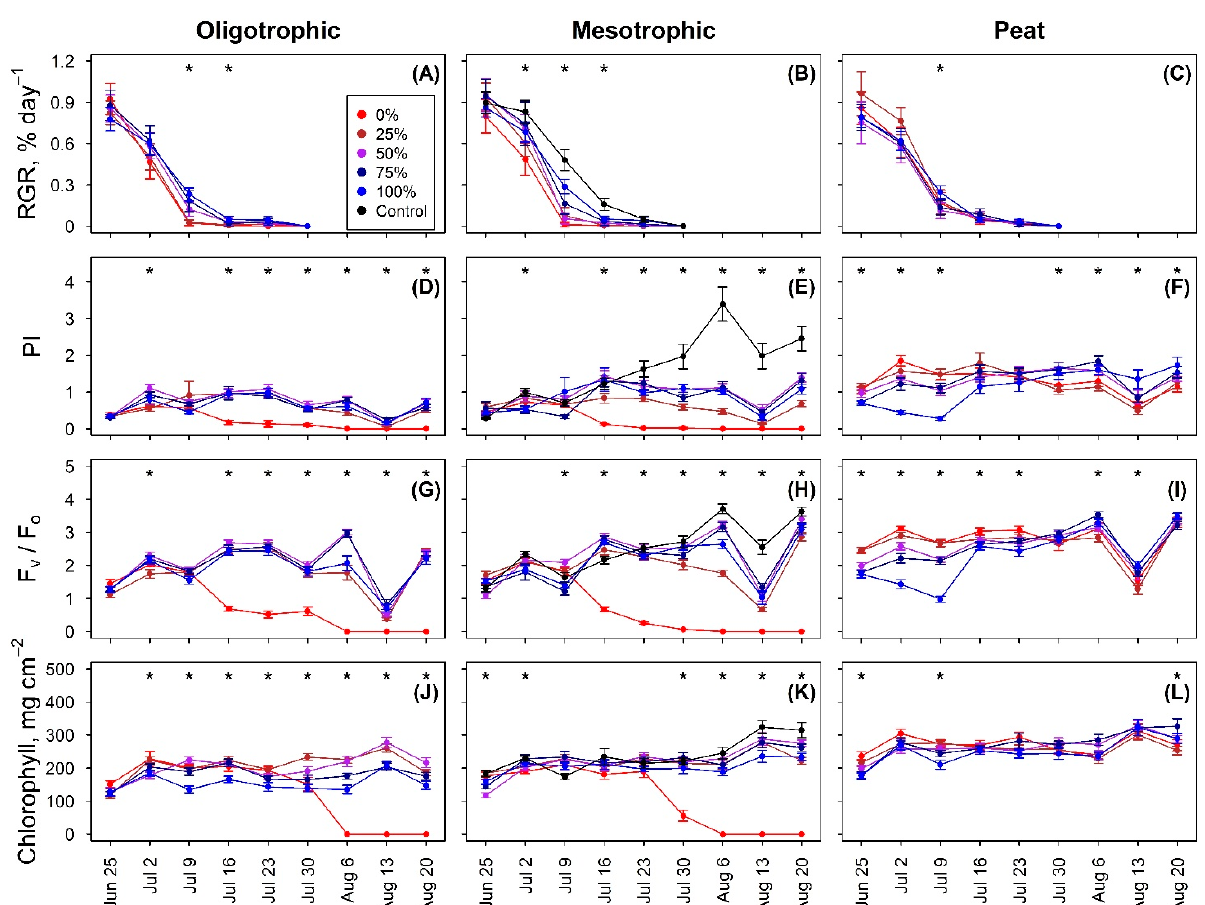
Figure 4. The intra-annual dynamics of relative growth rate (RGR, A – C ), photosynthetic performance index (PI; D – F ), F v /F 0 ratio ( G–I ), and chlorophyll concentration ( J–L ) in the second-year needles of the third-year seedlings of Norway spruce according to soil type and irrigation intensity (proportion of natural precipitation; indicated by colours). The whiskers denote 95% confidence intervals. The asterisks above the points indicate significant ( p -value < 0.05) differences among the irrigation intensities (the control was excluded from the calculation).